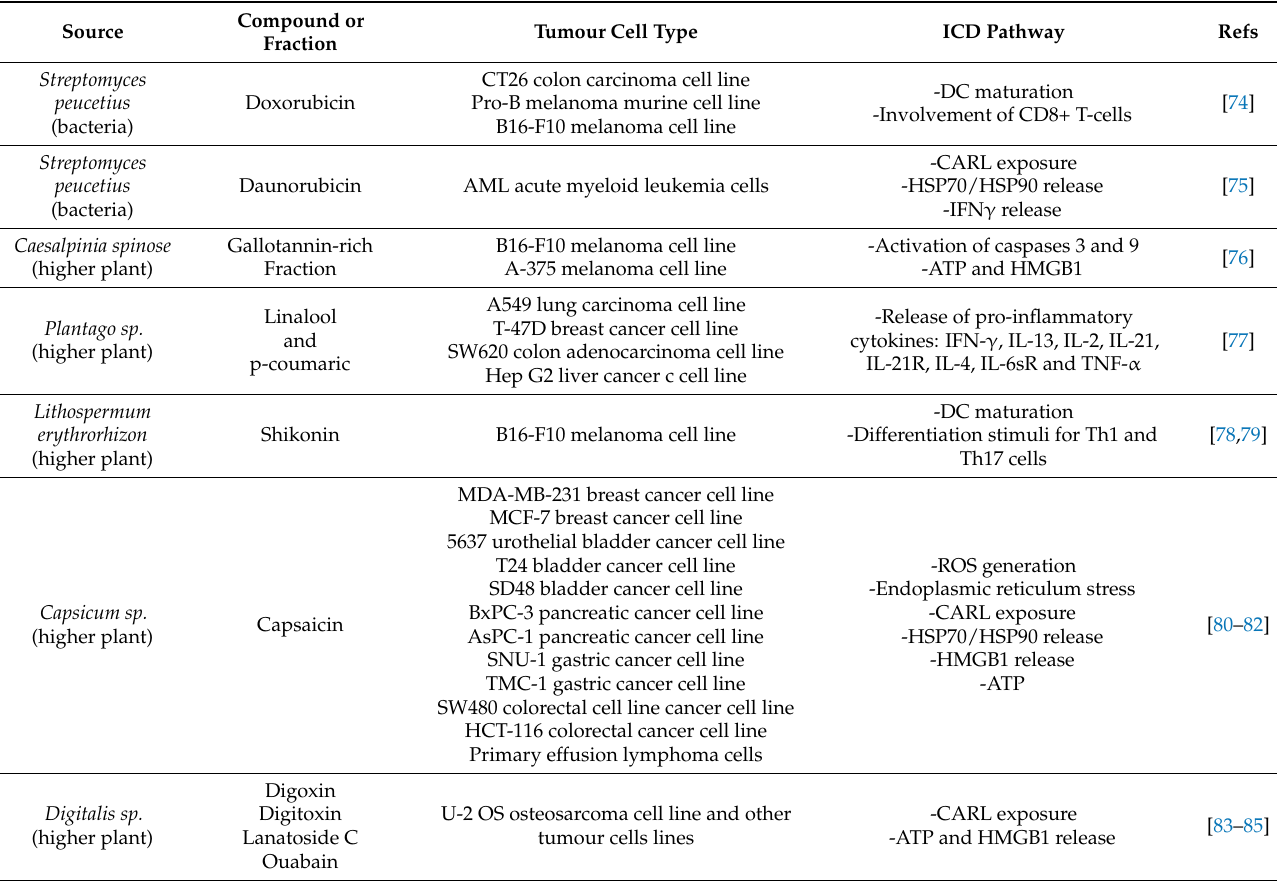
Table 1. Natural compounds and relative immunogenic cell death (ICD)-related molecular mechanisms. Selected natural compounds and related ICD activities are shown, clustered for tumour cell type target and ICD properties. (sp. is species)